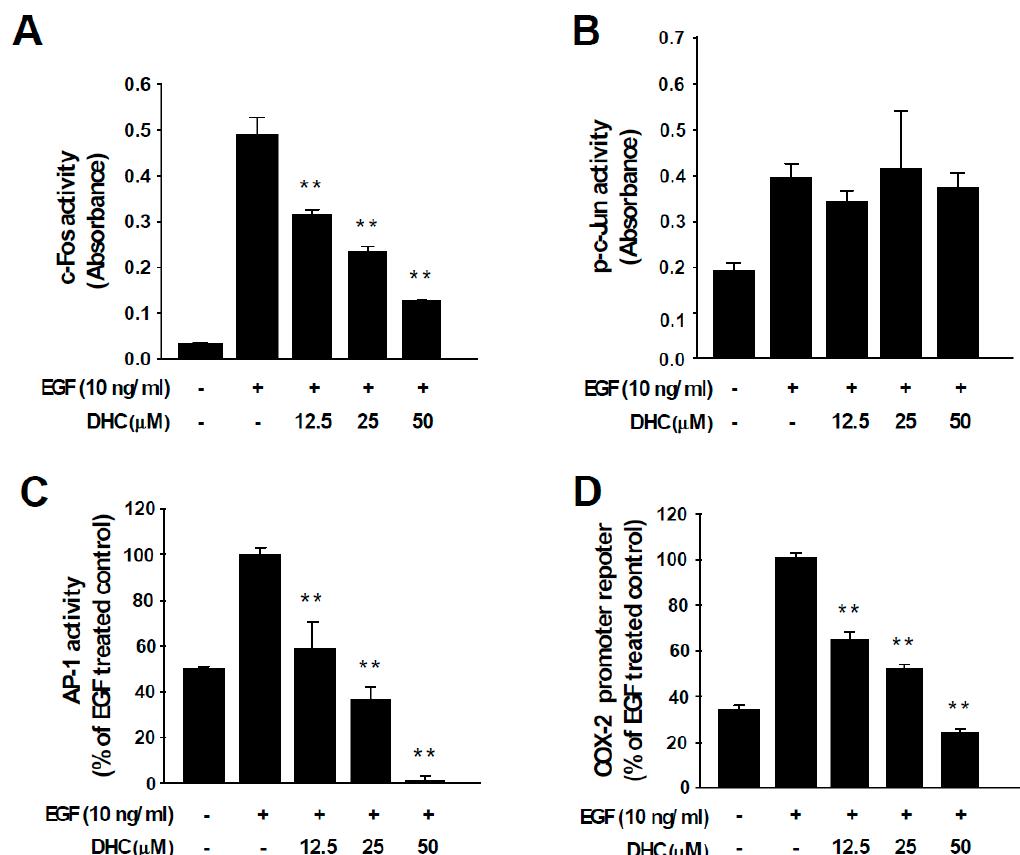
Figure 3. Effect of dihydrocapsaicin on EGF-induced c-Fos, c-Jun, and AP-1 activities and COX-2 promoter activity. ( A, B ) TransAM™ AP-1 family transcription assay kit was used to assess c-Fos and c-Jun activity. Nuclear protein extracts from JB6 P+ cells were used after the indicated treatment. Data are presented as means ± S.D. ( C ) JB6 P+ cells stably expressing an AP-1 luciferase reporter plasmid were treated as indicated. ( D ) JB6 P+ cells stably expressing COX-2 promoter reporter plasmid were treated as indicated. ** p < 0.01, significant differences between the group treated with EGF alone and co-treated with dihydrocapsaicin and EGF.